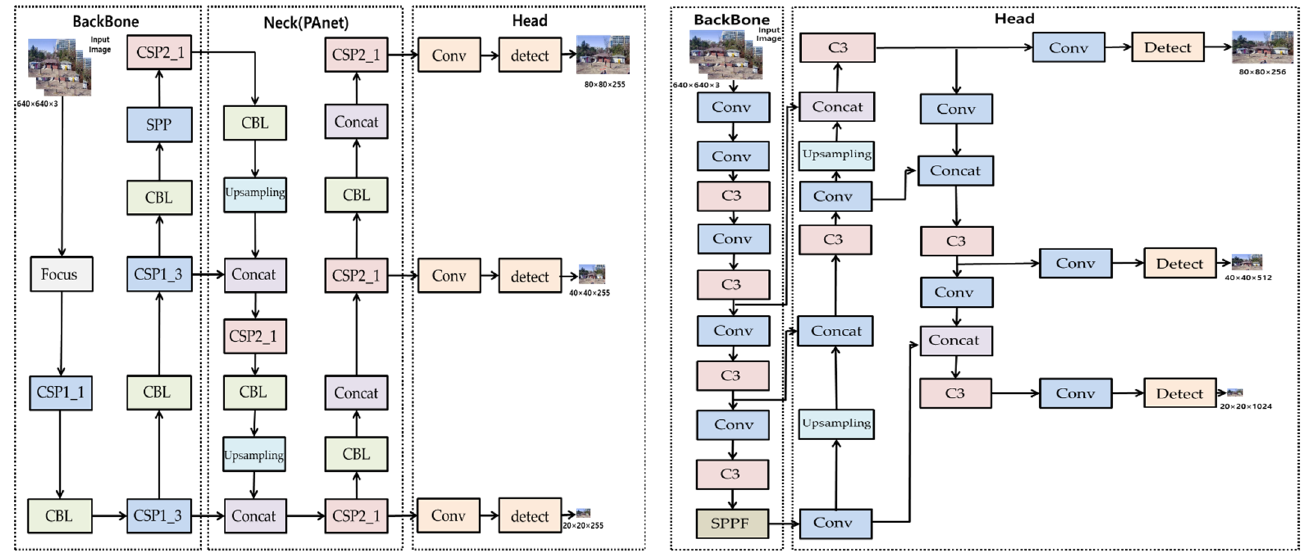
Figure 1. Structure comparison of previous and current YOLOv5 ( Left figure is previous, Right figure is current YOLOv5) .